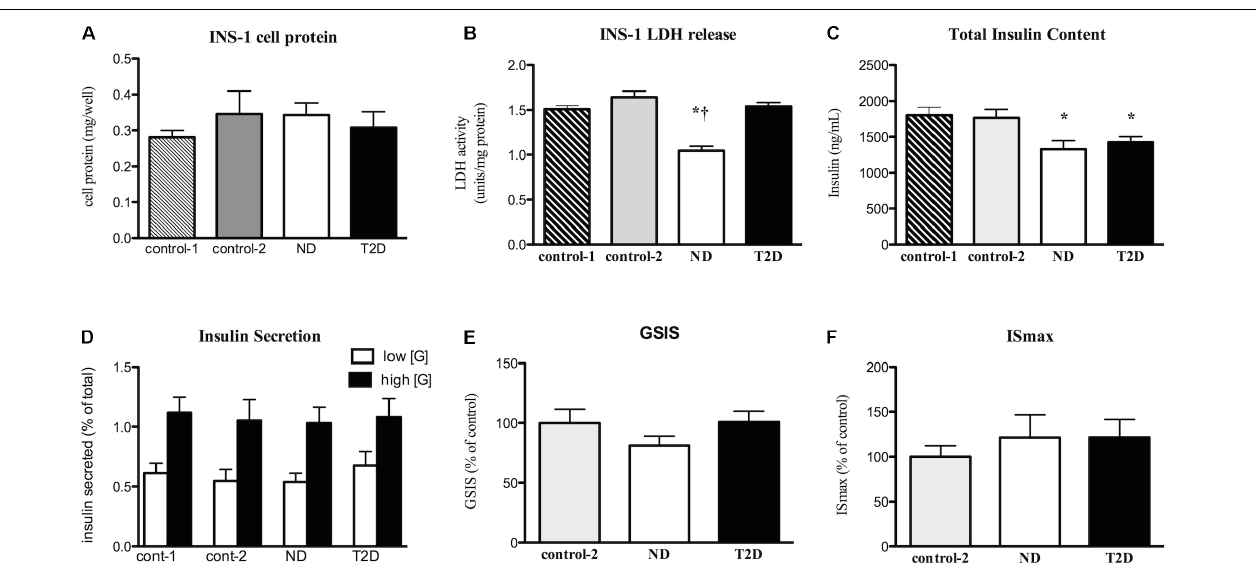
FIGURE 3 | Effects of myotube (MT) conditioned media (CM) on INS-1 cell viability and function. Serum-free CM collected after 24 h and processed as described in the section “Materials and Methods.” INS-1 cells treated with the indicated media for 24 h before harvest or assay. (A) Total cell protein ( n = 12). (B) LDH release ( n = 12). (C) Total insulin content ( n = 20). (D) Insulin secretion in the presence of low (2.5 mM) and high (16.5 mM) glucose ( n = 11/11/16/12). (E) GSIS ( n = 20). (F) Maximal, IMBX-stimulated, insulin secretion (IS max , n = 8). Results presented as absolute value (A–D) or as a percentage of Control-1 media (E,F) , Ave + SEM. Control 1 = RPMI, Control 2 = RPMI: α MEM (3:1) not conditioned by MT. “ n ” represents the number of independent determinations, CM from MT from separate individuals, each performed in duplicate. * p < 0.05 vs. controls, † p < 0.05 vs.